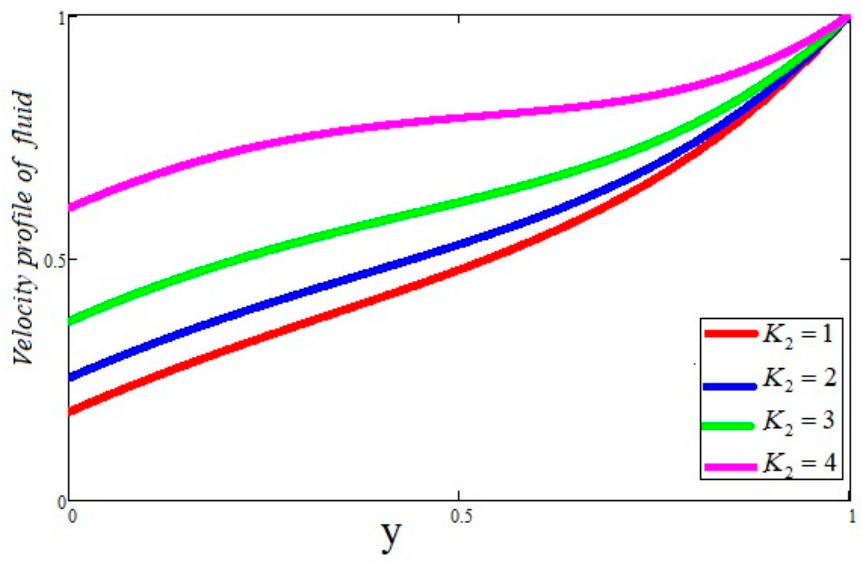
Figure 4. Impact of K 2 on the profile of fluid velocity.